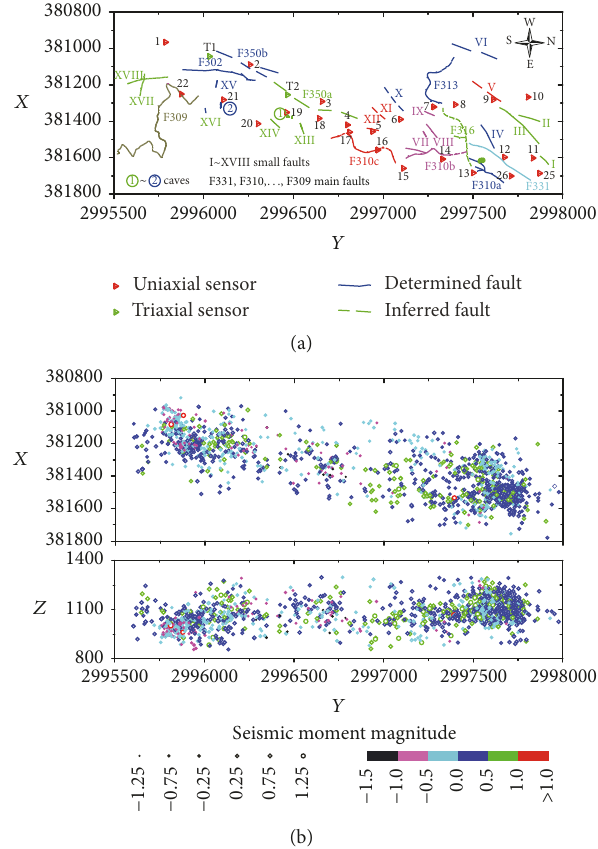
Figure 2: Distributions of geological structures, sensors, and seis- miceventsoftheYongshabamine.(a)Thedistributionsofgeological structures and sensors. The solid lines represent determined faults, while the dashed lines represent inferred faults by mine geologists. The symbols A and B represent two caves, and the triangles represent the location of sensors. The numbers near the sensors are the sensor numbers, T1 and T2 are triaxial sensors, and the sensors from1to26areuniaxialones.(b)Thedistributionsofseismicevents. The color and the size of the circle represent the seismic moment